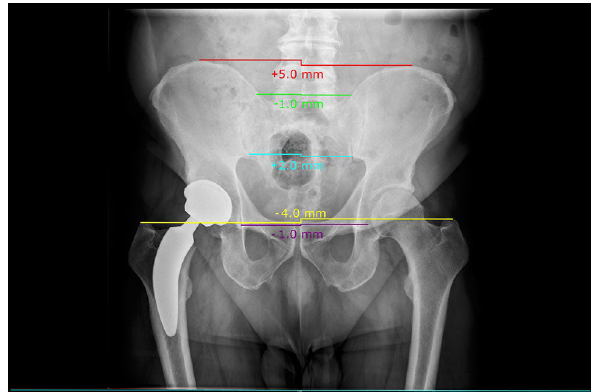
Figure 1. Anatomical landmarks for LLD measures (yellow = trochanter; purple = tear drop figure; blue = lower sacroiliac joint; green = upper sacroiliac joint; red = iliac crest) as measured with mediCAD 2D ( Hectec GmbH)